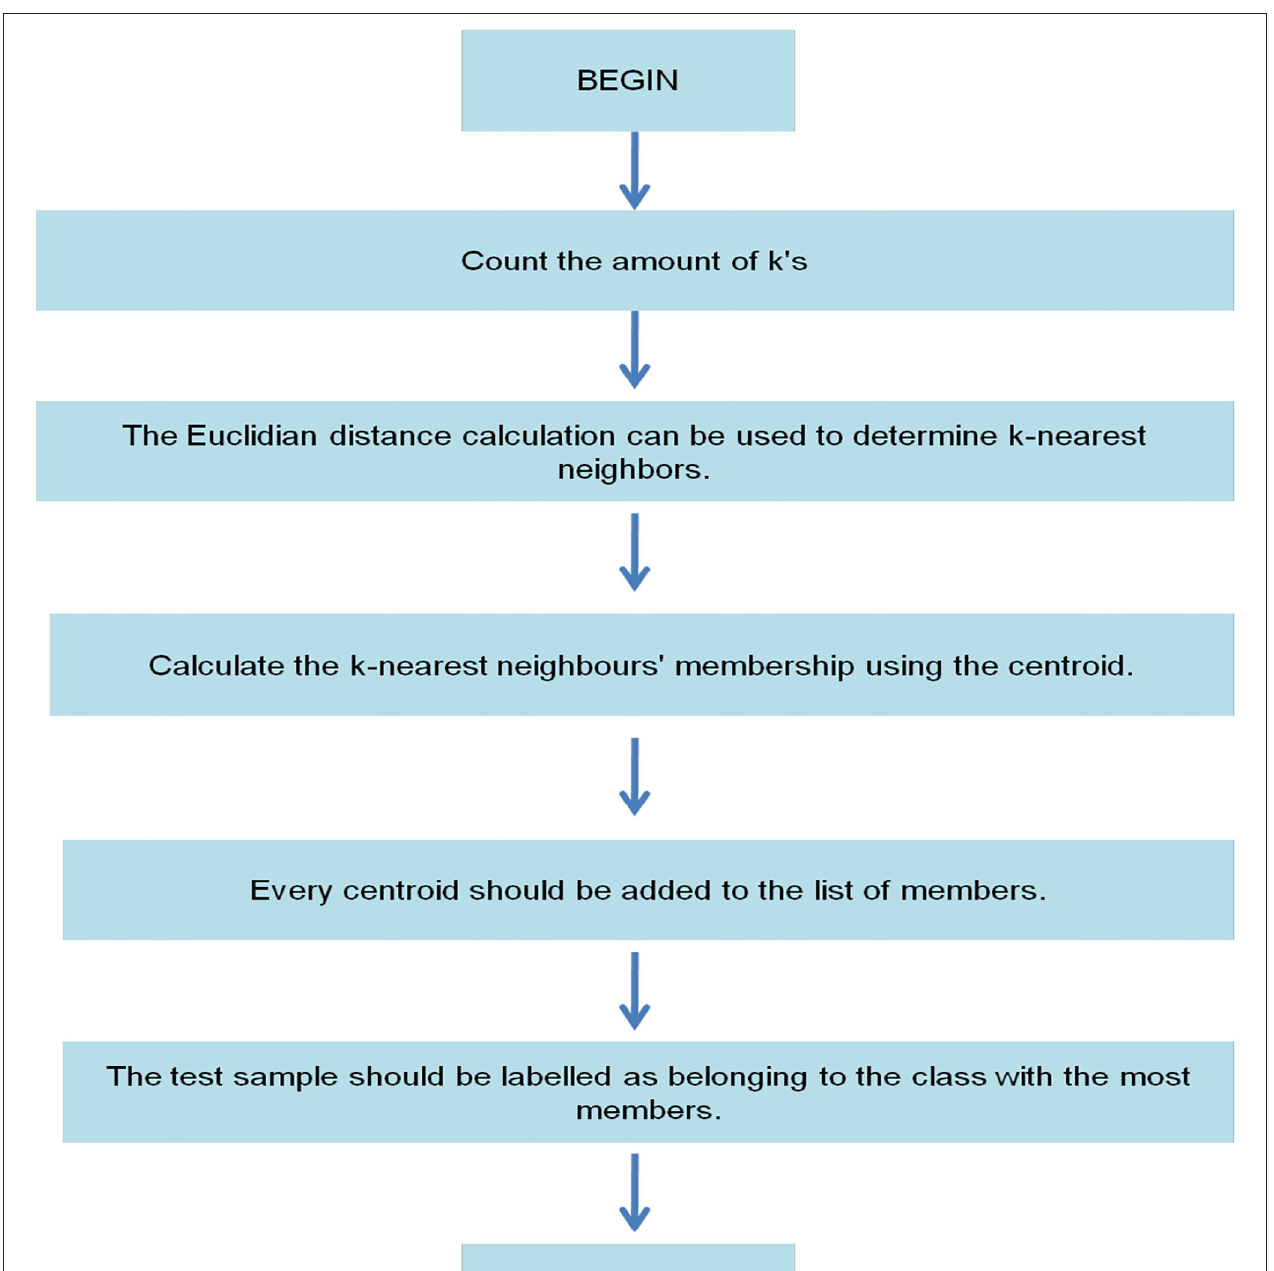
FIGURE 6 | Flow process of